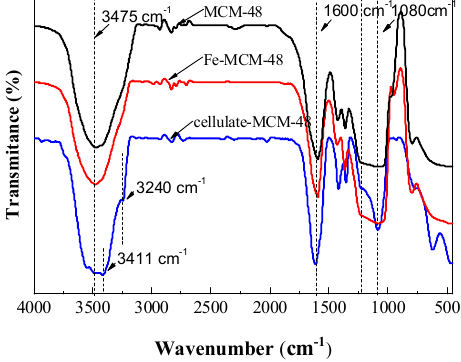
Figure 3. FT-IR spectra of MCM-48 supported catalysts.